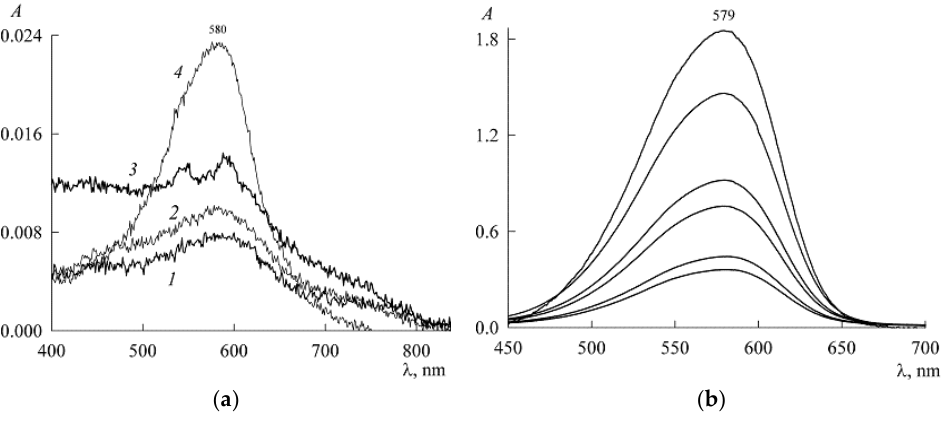
Figure 3. Absorption spectra of saturated NR solutions (with a content of 440 μM in the dispersion) in the presence of SDS at concentrations c 1 , mM: ( a ) 1.5 (1), 3 (2), 5.2 (3), and 7.2 (4); ( b ) from bottom to top: 9.1, 10.3, 12.3, 14.4, 19.4, and 21.